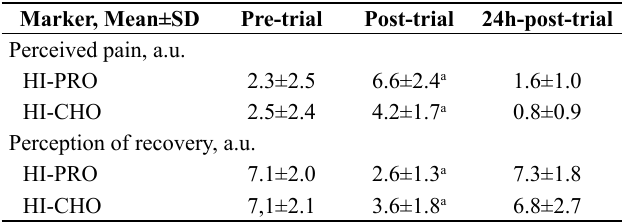
Table 2. Perceived pain and perception of recovery at pre-, post- and 24h-post-trial in HI-PRO and HI-CHO conditions. Marker, Mean±SD Pre-trial Post-trial 24h-post-trial Perceived pain,